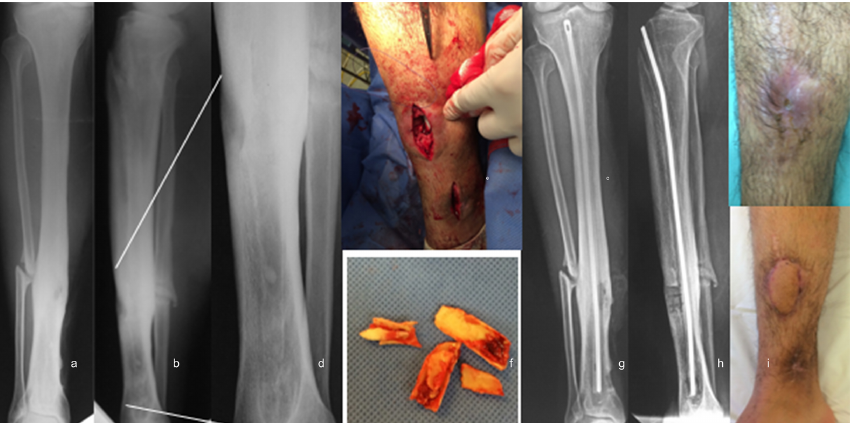
Figure 2. Osteomyelitis of the tibia treated with a custom-made ATB-cemented nail at another center. (a–c) AP and lateral radiographs showing intracanal cement debonding and clinical image with active fistula in the leg. (d) Higher zoom image of the lateral radiograph, to highlight the cement remnants inside the tibia. (e, f) Intraoperative images, showing the locations where the bone windows were made (at the level of the fistula and distally for the removal of the intracanal cement) and the cement remnants removed. (g, h) AP and lateral radiographs at 30 months after reaming and placement of an ATB-cemented nail with infection control. (i) Good evolution of the treatment of the soft tissue coverage defect.